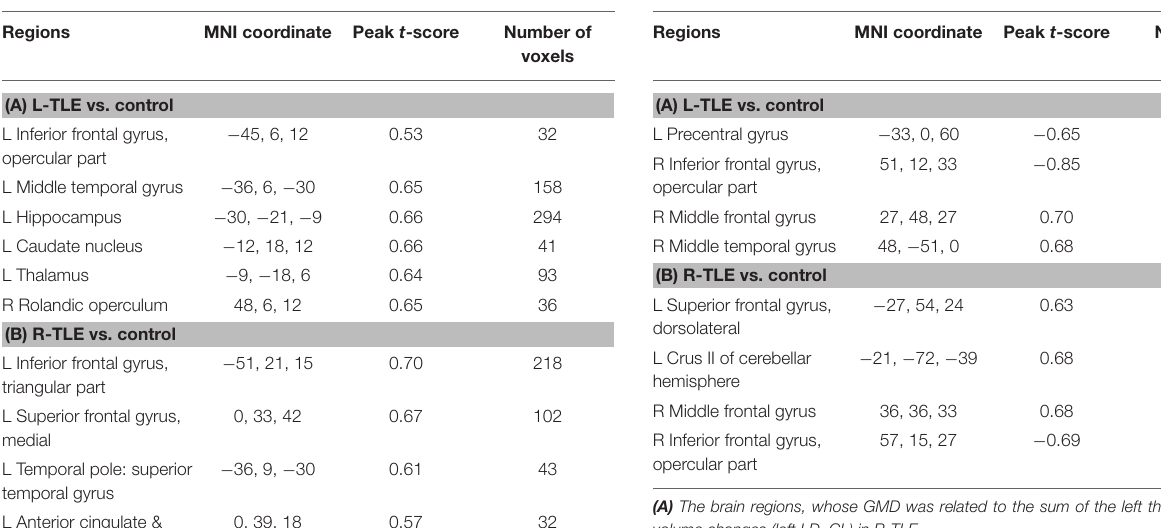
(B) The brain regions, whose GMD was related to the sum of the right thalamic subfield volume changes [right AV, LD, LP, VA, Vamc, CeM, MV(Re), MDl, L-Sg] in R-TLE. The results are listed below, and are also depicted in Figure 5 . The values given are the stereotactic MNI coordinates and the t-score of each anatomical region. SPM maps used a threshold of p < 0.01 (AlphaSim correction, voxel-level, minimum cluster size threshold of 19 voxels). Age and gender as covariates. MNI, Montreal Neurological